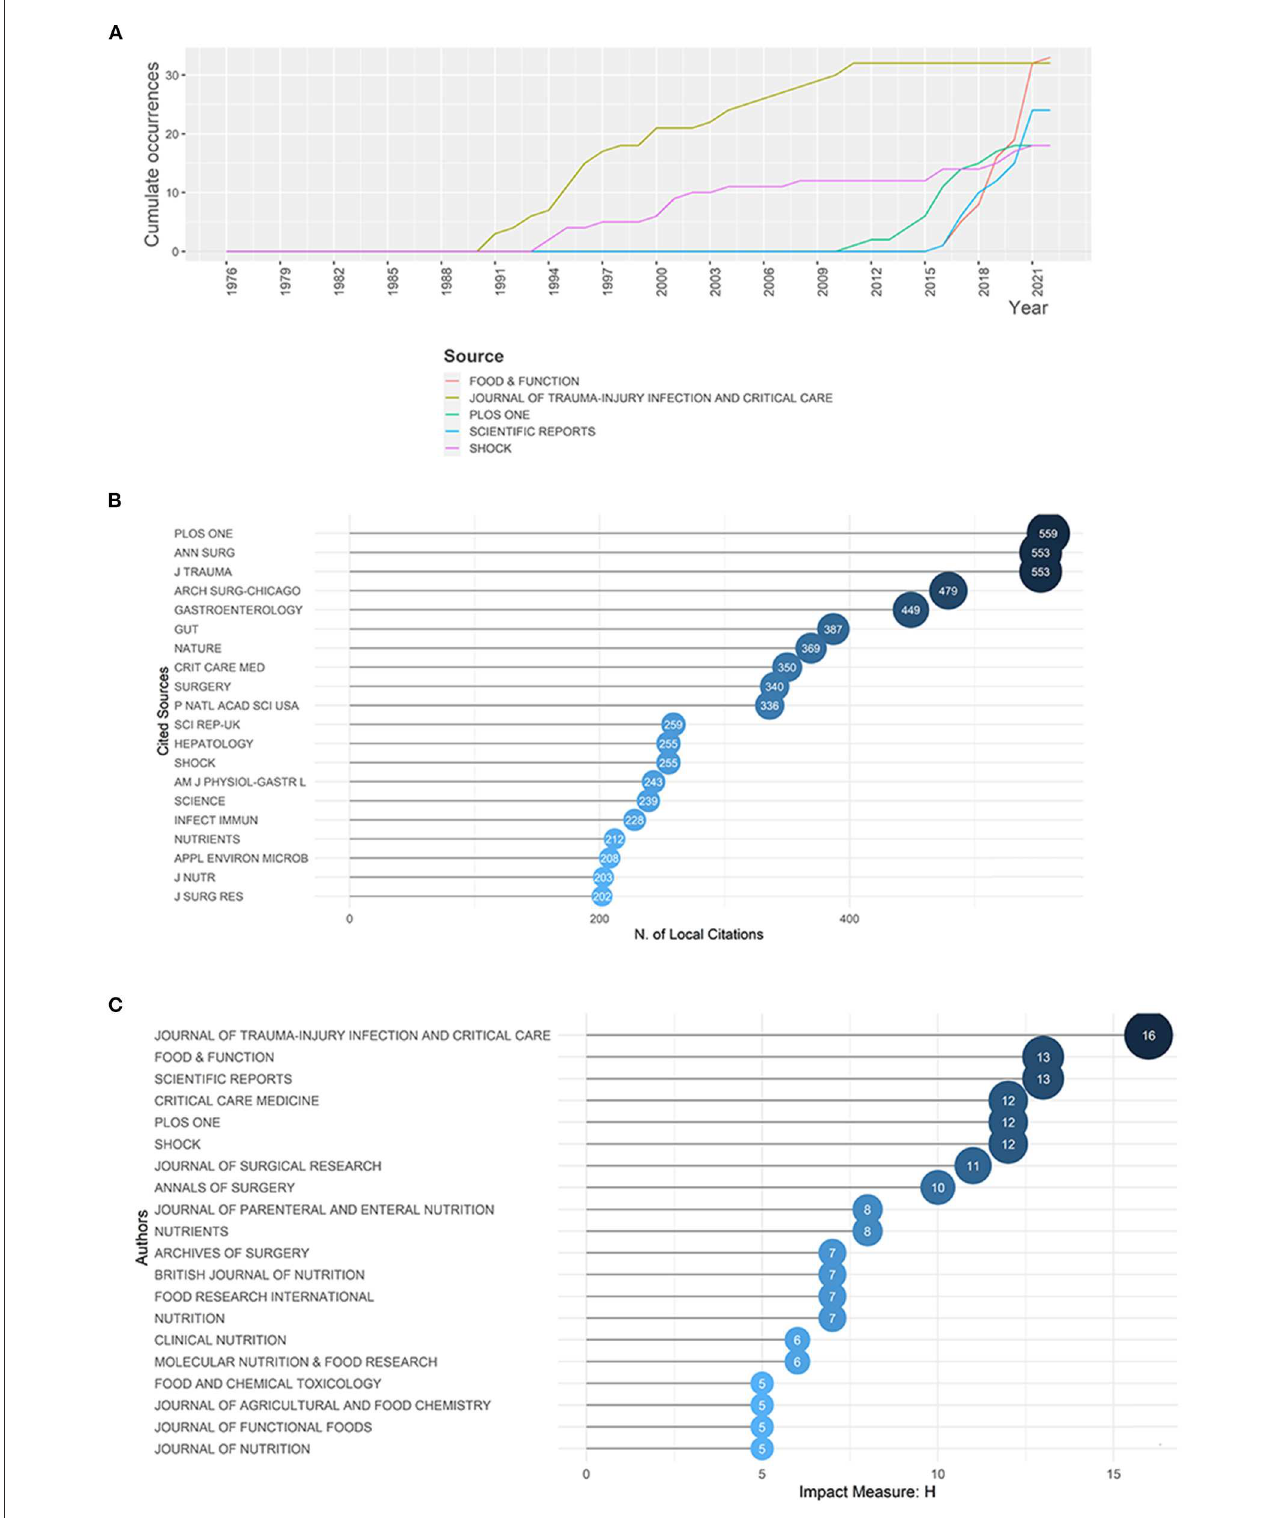
FIGURE5 (A) The publications’ growth of top five productive journals in gut microbiota and trauma research. (B) Top 20 most local cited journals in gut microbiota and trauma research. (C) Most local impactive journals measured by h-index in gut microbiota and trauma research.